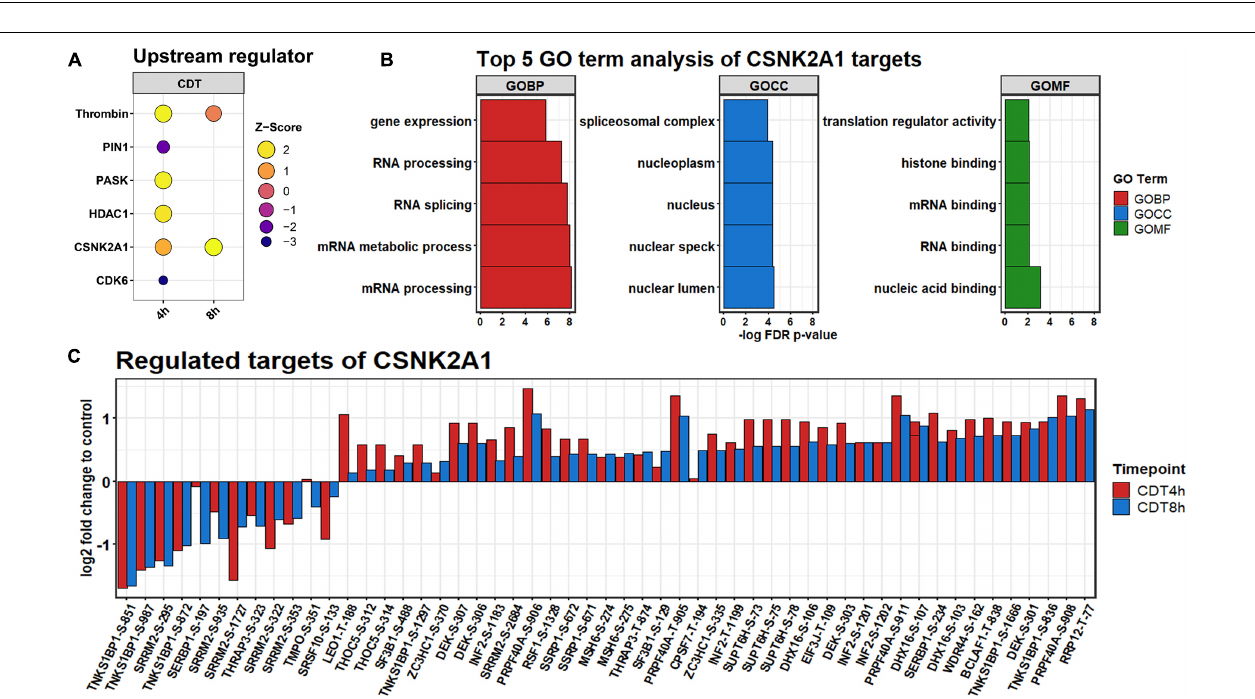
FIGURE 5 | (A) Upstream regulators predicted by IPATM. (B) Regulation of significantly changed predicted downstream phosphosite targets of CSNK2A1 after 4 h (red) and 8 h (blue) of CDT treatment. (C) GO analysis of predicted targets.